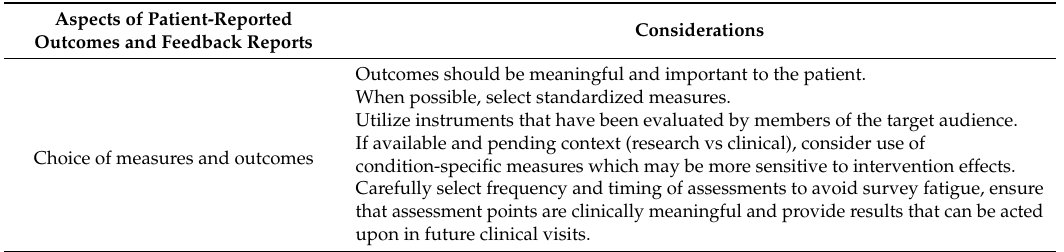
Table 2. Suggestions for use of patient-reported outcomes (PRO) and feedback reports in the clinical